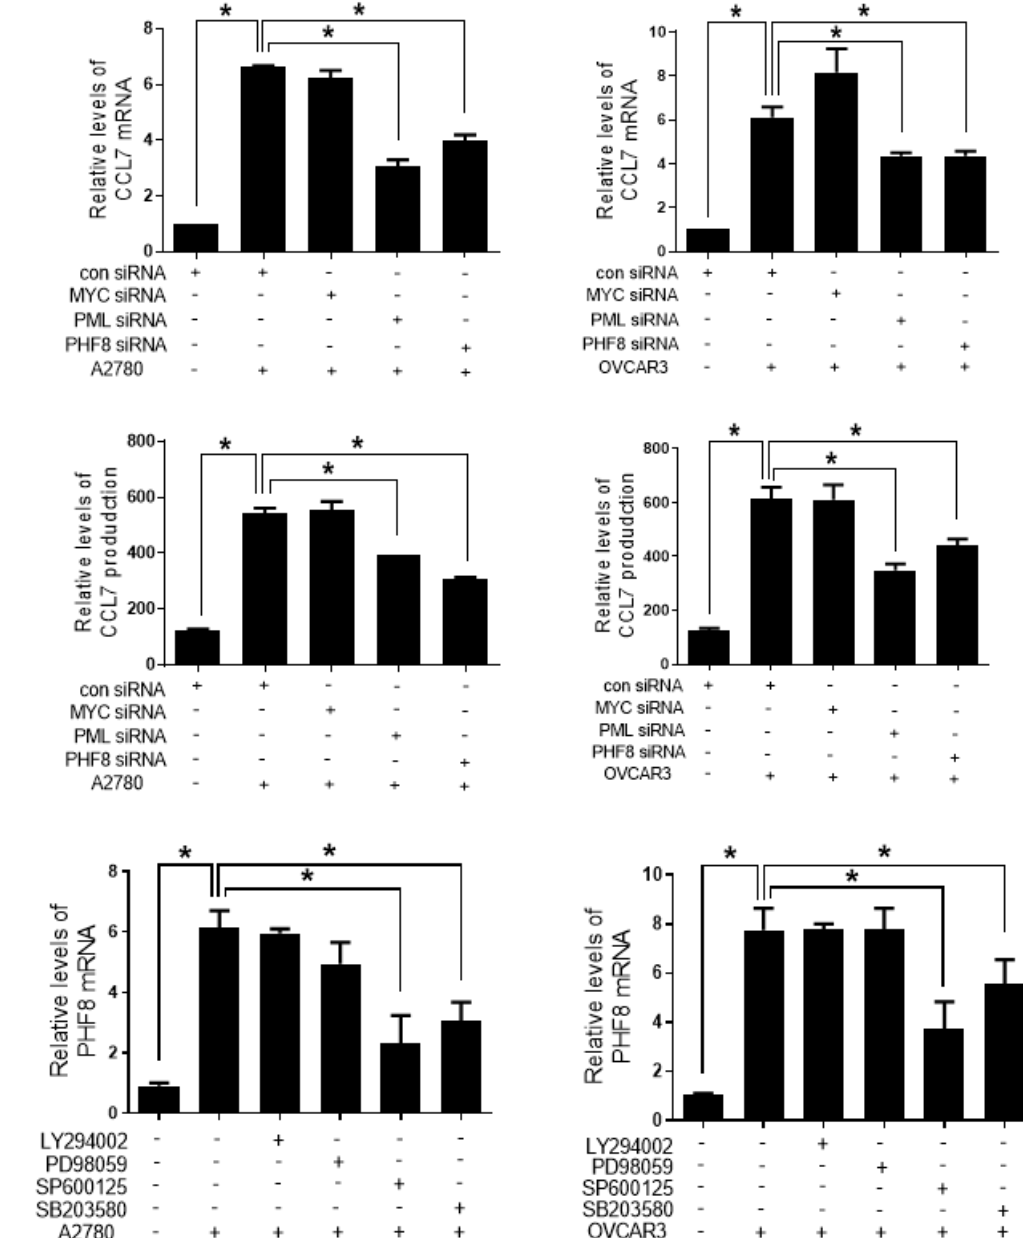
Figure 5. Involvement of PHF8 in CC chemokine ligand 7 (CCL7) expression in macrophages stimulated by ovarian cancer cells. ( A , B ) Macrophages were transfected with MYC, PML, or PHF8 siRNA (50 nM), or control siRNA, then treated with the conditioned medium (CM) of A2780 and OVCAR3 cells for 24 h. ( A ) The mRNA levels of CCL7 were measured by the real-time polymerase chain reaction. ( B ) The levels of CCL7 in the medium of macrophages were measured by an enzyme-linked immunoassay kit. ( C ) Macrophages were pretreated with the PI3K inhibitor, LY294002 (20 µM), MAPK/ERK Kinase (MEK) inhibitor, PD98059 (70 µM), JNK inhibitor, SP600125 (20 µM), or p38 inhibitor, SB203580 (20 µM), for 1 h, then with the CM of A2780 and OVCAR3 cells for 24 h. The mRNA levels of PHF8 were measured by the RT-PCR. * p < 0.05.